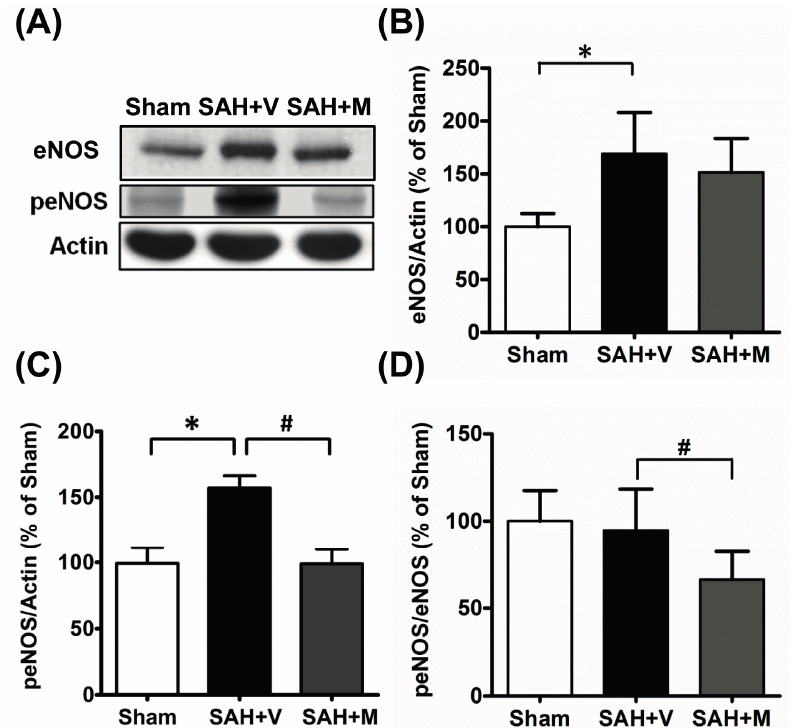
Figure 3. Memantine diminished the expression of phosphorylated endothelial nitric oxide synthase. ( A ) Representative Western blots probed for endothelial nitric oxide synthase (eNOS) and phosphorylated eNOS in the brain tissue; Corresponding bar graphs showed statistically significant up-regulation of eNOS ( B ) and phosphorylated eNOS ( C ) in SAH + V animals compared to the sham-operated group; and ( D ) Treatment with memantine significantly restored phosphorylated eNOS level. * p < 0.05 vs. sham, # p < 0.05 vs. SAH +